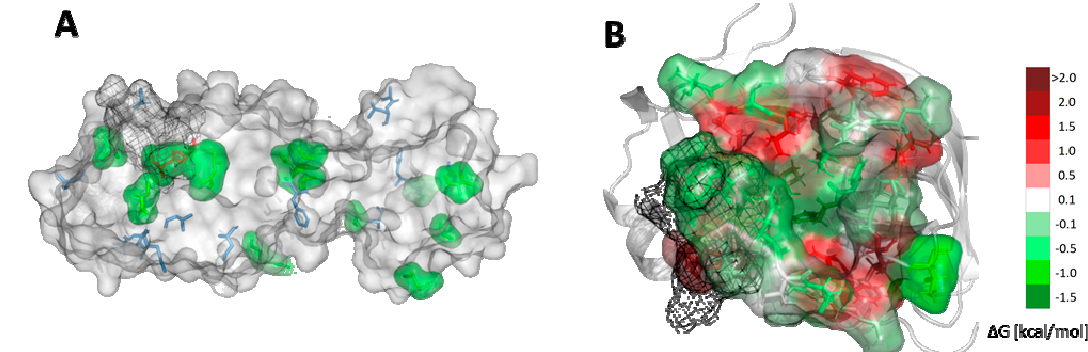
Figure 6. Potential mutability of SARS-CoV-2 Mpro. ( A ) Structure of SARS-CoV-2 Mpro with the most energetically favourable potential mutations of amino acids marked as green surface. Positions of amino acids that di ff er from the ones in SARS-CoV Mpro structure marked as blue sticks. Catalytic dyad marked as red. ( B ) The catalytic site of SARS-CoV-2 Mpro is shown as surface with the most energetically favourable potential mutations shown as green, neutral as white, and unfavourable as red. The C44-P52 loop is shown as black mesh.